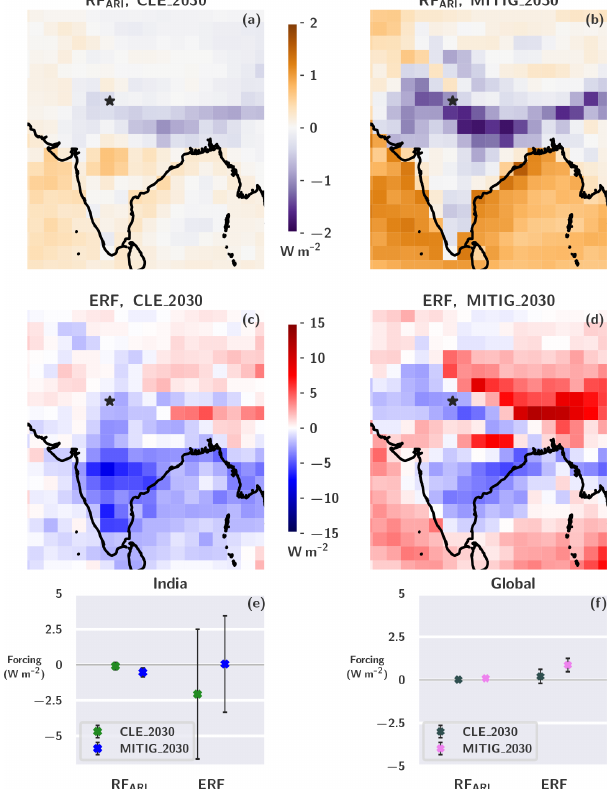
Figure 3. The spatial RF ARI and ERF for the CLE_2030 (a, c) and MITIG_2030 (b, d) simulations. The Indian (e) and global averages (f) for RF ARI and ERF are shown with green, blue, dark-gray and pink markers, respectively. The whiskers represent the combined standard